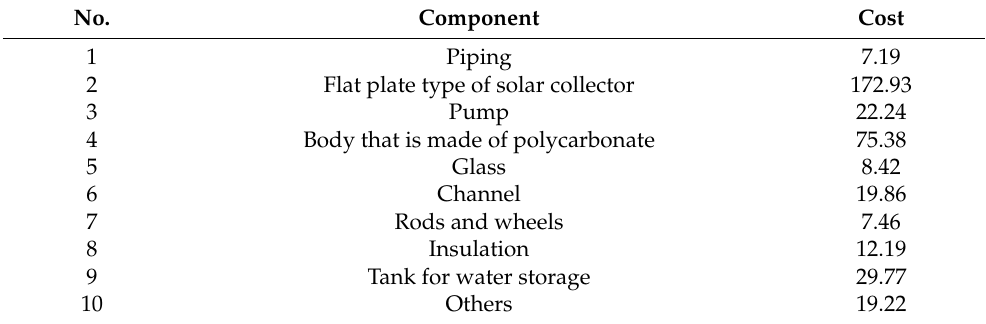
Table 2. Components of the studied solar still in addition to their cost; all the values for cost are in US dollars [15].